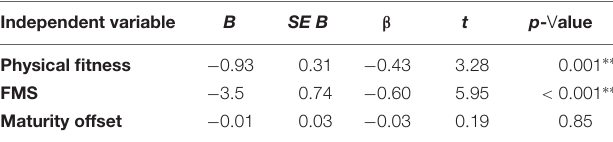
TABLE 4 | Linear regressions of physical fitness, FMS and maturity offset on speed dribbling. Independent variable